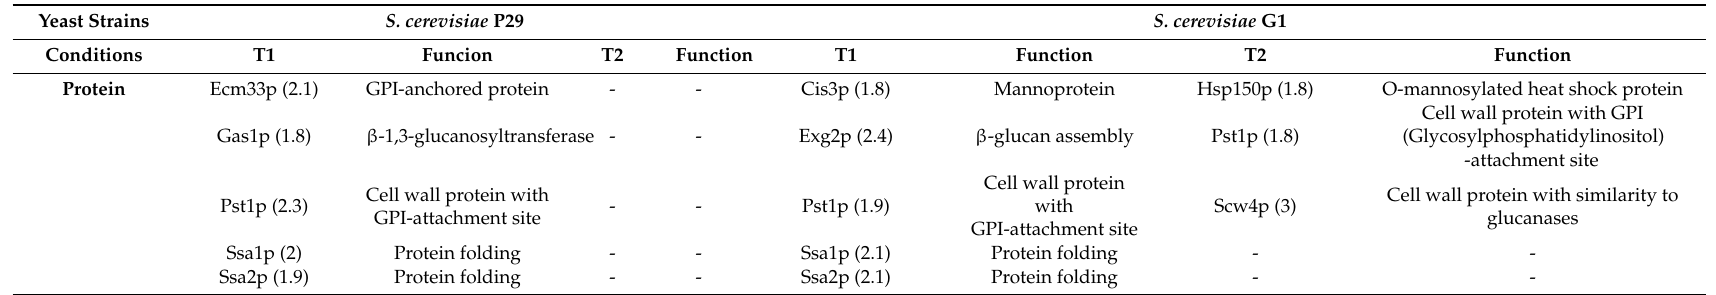
Table 1. Over-represented proteins detected under pressure conditions (PC) in both yeast strains S. cerevisiae P29 and G1, at the middle of the second fermentation (T1) and one month after it (T2). Molecular function and fold change in brackets are shown. Only proteins with fold changes of protein content ≥ 1.8 are shown. GPI: